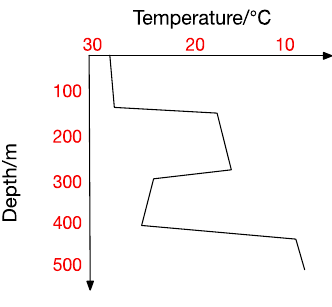
Figure 5. Mix Thermocline.